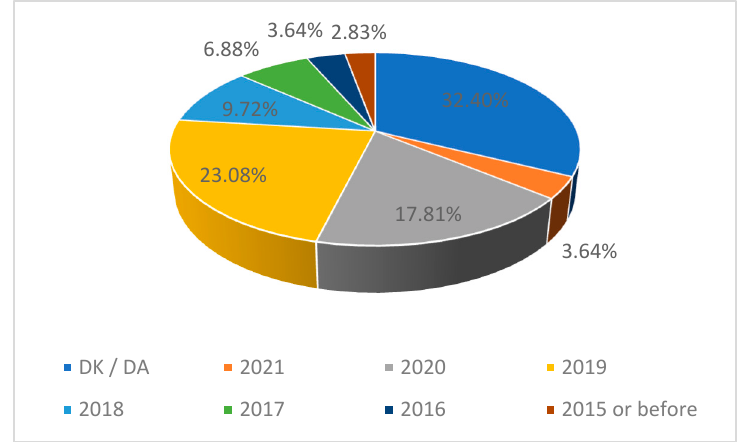
Figure 3. Graph of year in which respondents started listening to podcasts/Source: Prepared by the author.